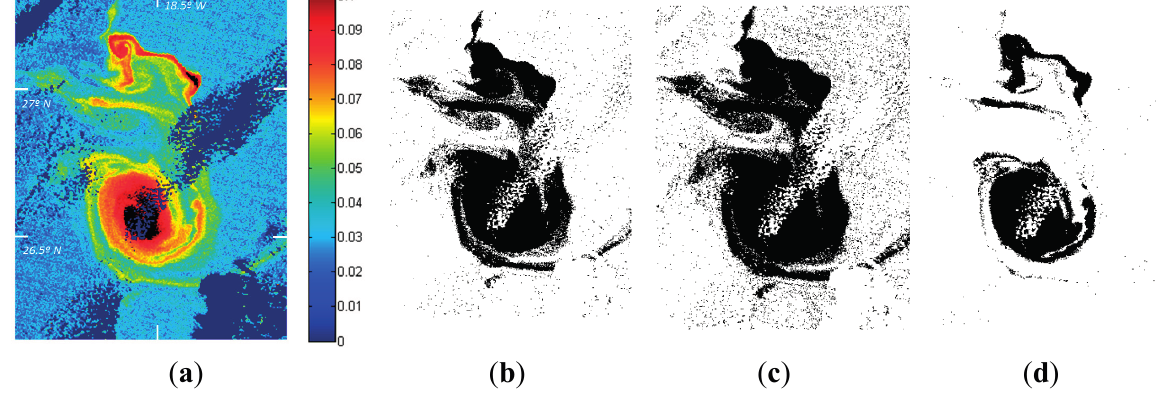
Figure 5. Structures detected by different segmentation algorithms: ( a ) K d pre-processed imagery; ( b ) K-means; ( c ) Fuzzy K-Means; and ( d )